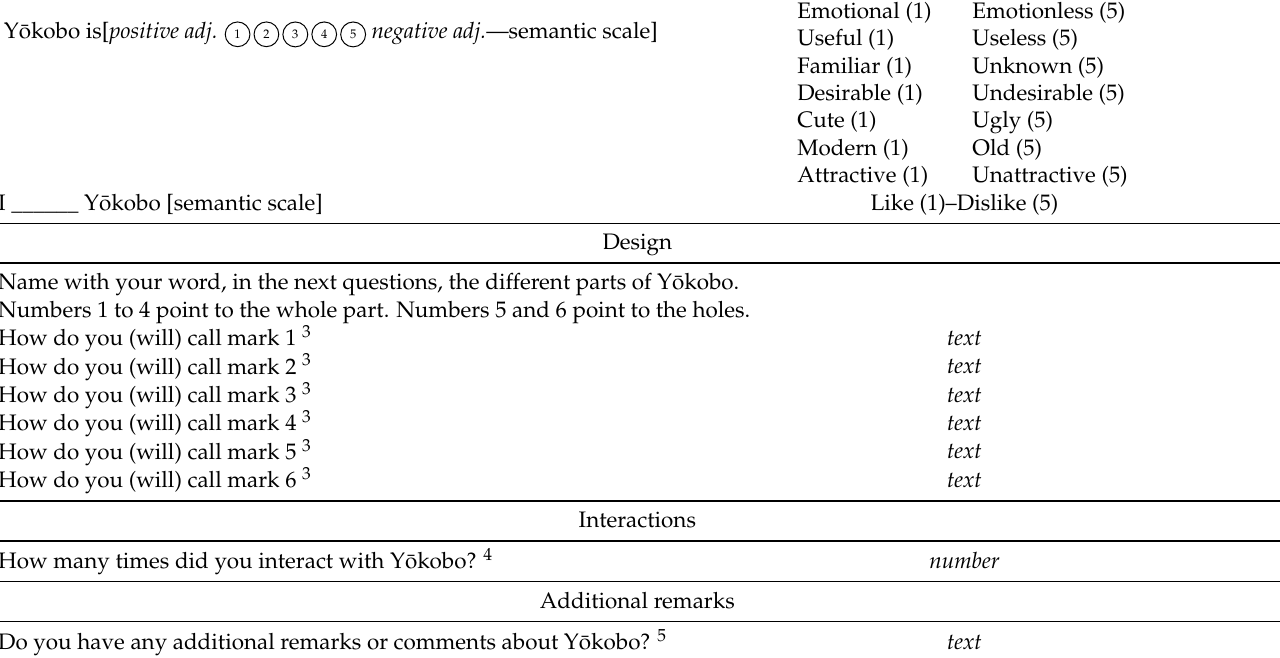
Figure A1. 4 Only for QW1 and QW2. 5 Only for